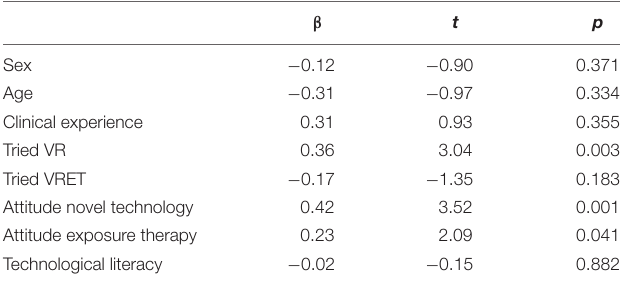
TABLE 3 | Predictors of general attitude to use of VR in therapy in the clinician sample.